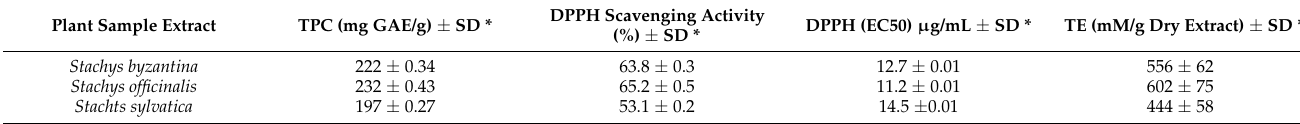
Table 1. Total amount of phenolic compounds and radical scavenging activity in S. byzantina , S. officinalis and S. sylvatica . Plant Sample Extract